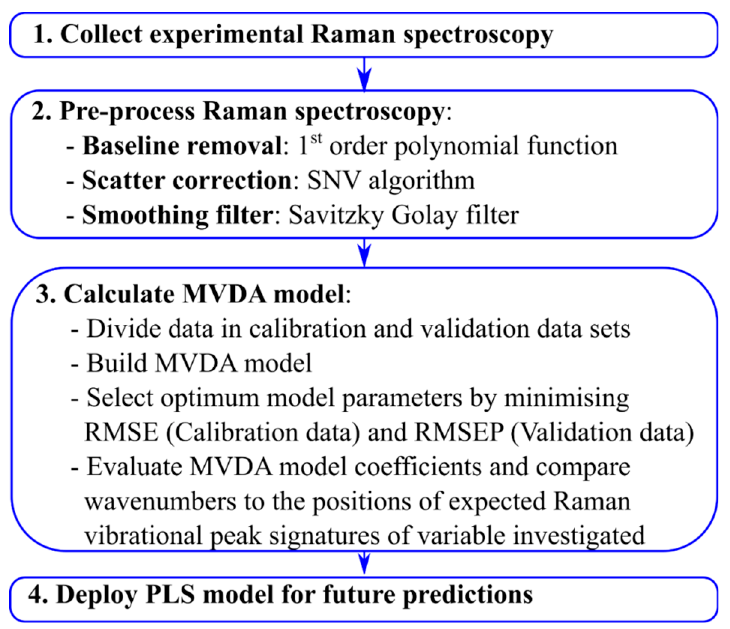
Figure 1. Raman spectroscopy model generation workflow defining the primary steps to ensure that a robust MVDA model is generated. SNV = standard normal variate, RMSE = root mean square, and RMSEP = root mean square error of prediction, MVDA = multivariate data analysis.